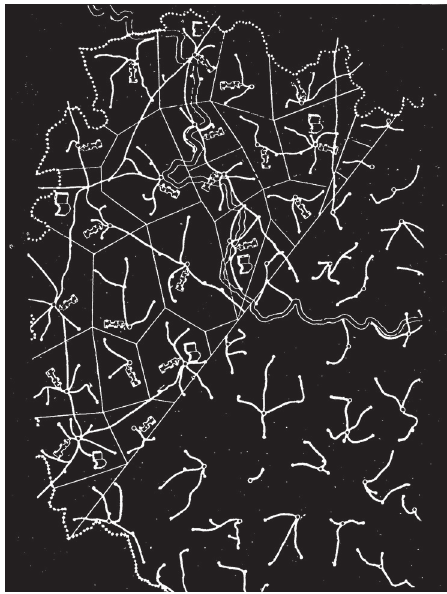
Fig. 9. Le Corbusier, Urbanisme des trois établissements humains (1945). Geoarquitecture, a particular version of Human Geography suggested by Le